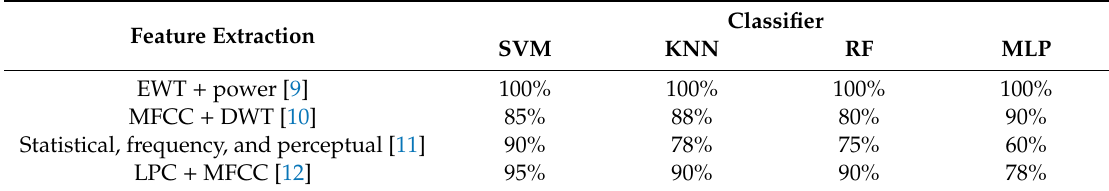
Table 7. Accuracy results of synthetic signals without applying an EWT algorithm, using the trained models proposed in articles